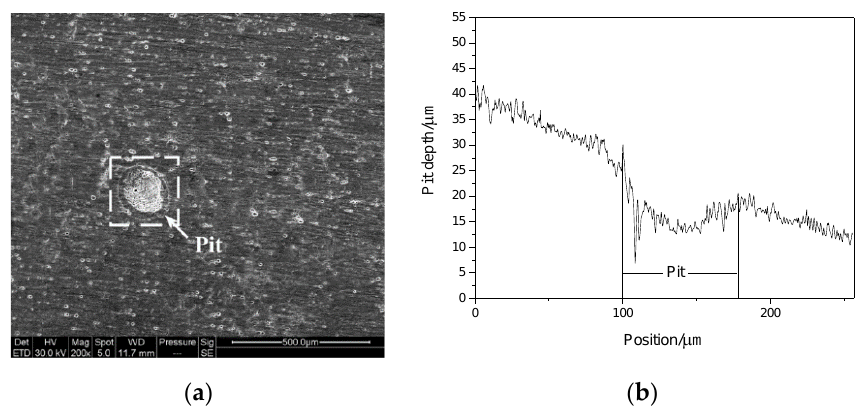
Figure 14. Morphology and dimension of a pit: ( a ) morphology and ( b ) dimension measurement.